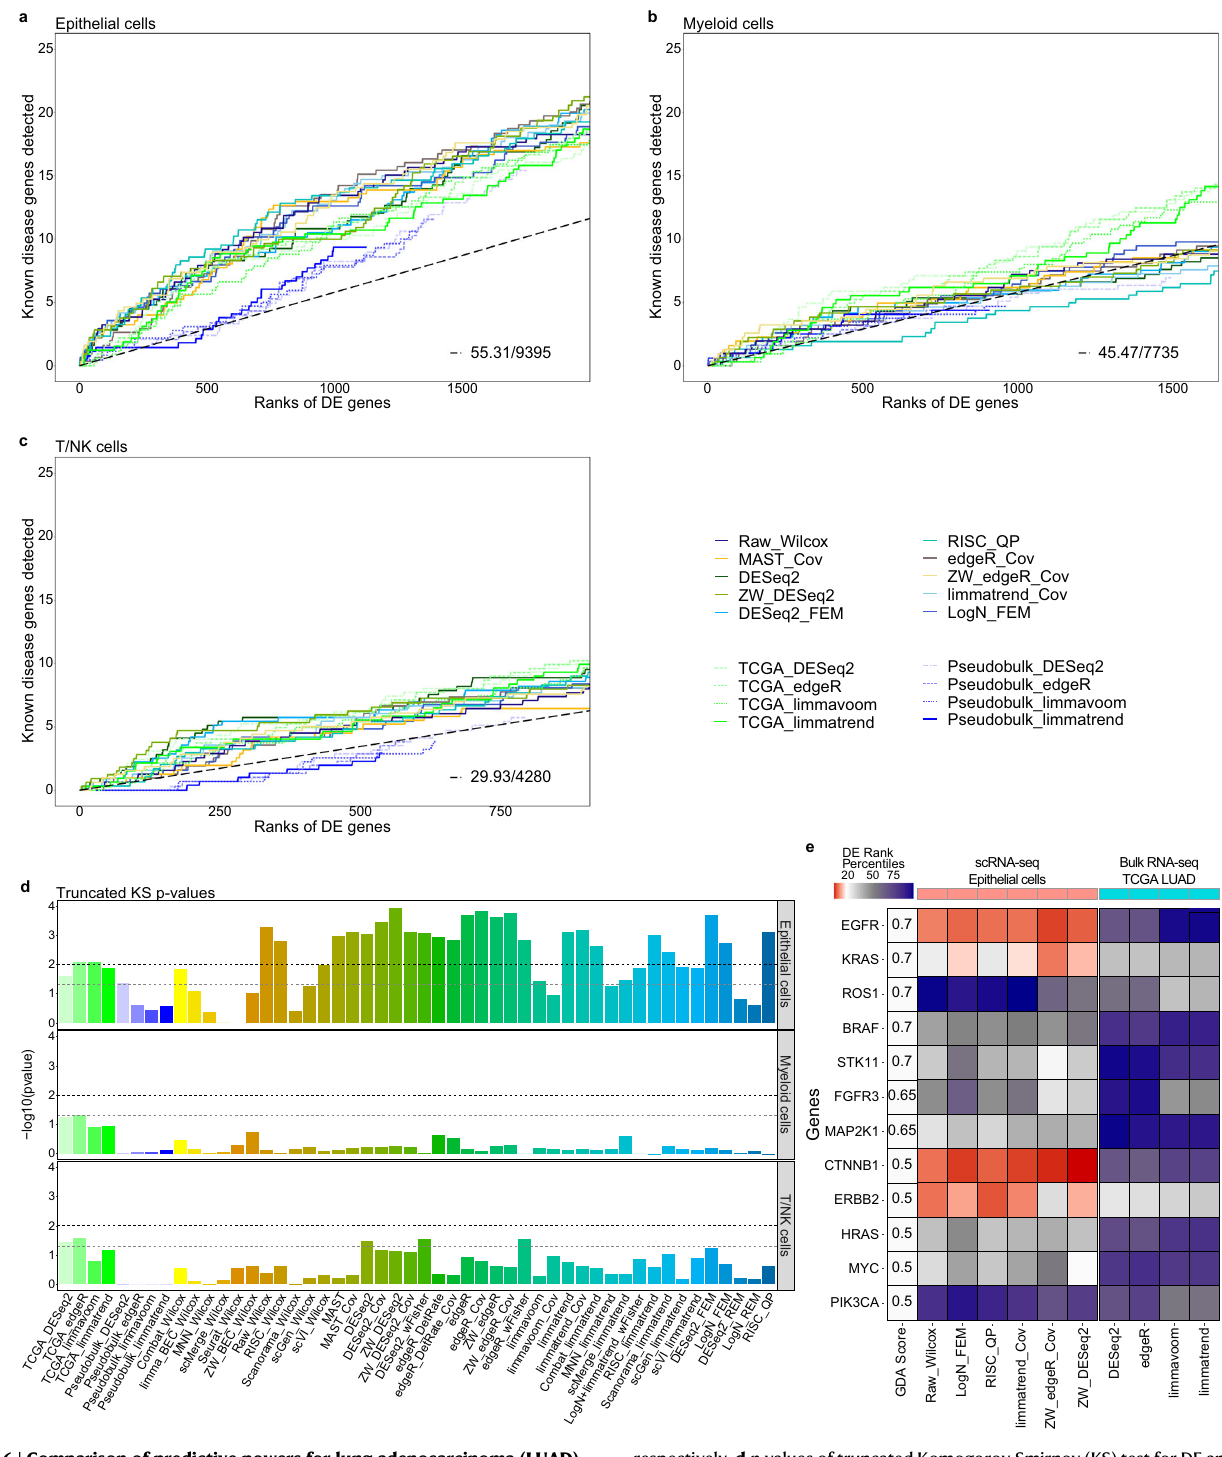
respectively. d p -valuesoftruncatedKomogorov-Smirnov(KS)testforDEanalyses of scRNA-seq and TCGARNA-seqdataare shown forthe three celltypes.Blackand gray dashes represent the two signi fi cance cutoffs p -values=0.01 and =0.05, respectively. e Rankpercentilesofthe12knownLUADgeneswithGDAscorenoless than0.5arevisualizedforsixDEwork fl owsappliedtoLUADepithelialcellsandfour bulk sample DE methods applied to TCGA LUAD data. n =7728, 17348, and 15293 cells were used for the analysis of epithelial, myeloid, and T/NK scRNA-seq data,